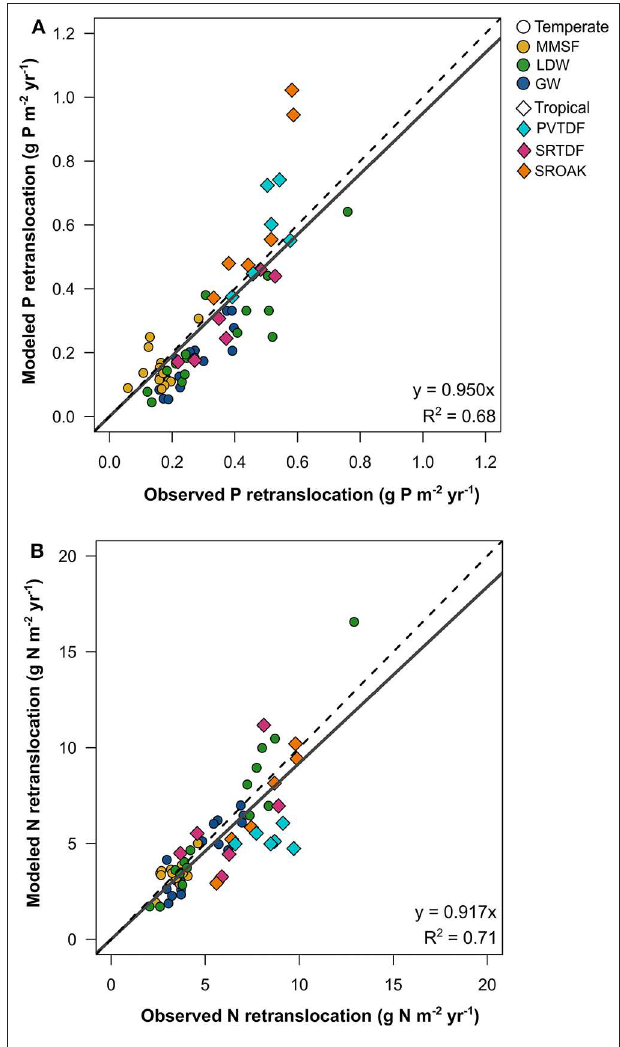
FIGURE 2 | Model predictions of (A) phosphorus and (B) nitrogen retranslocation across three temperate forest sites ( n = 45) and three tropical forest sites ( n = 18) that vary in mycorrhizal association. The dashed line represents the 1:1 relationship and the solid line represents the relationship between modeled and observed